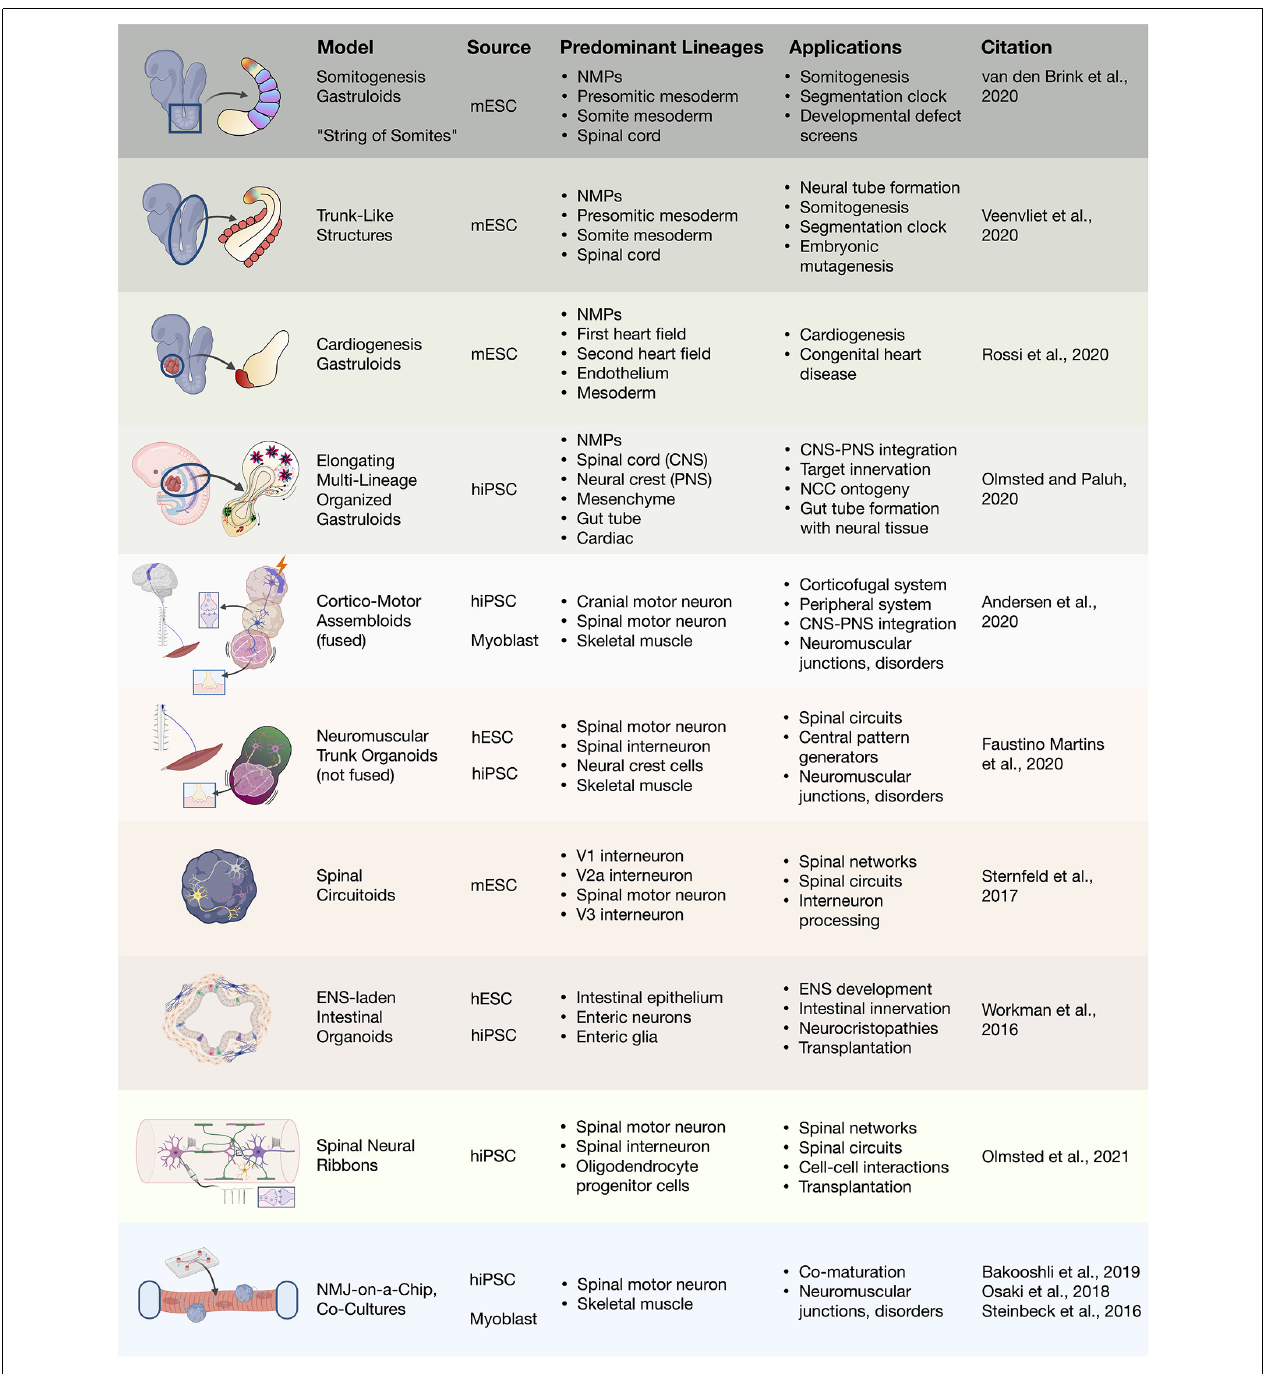
FIGURE 4 | 3D heterogenous cell culture developmental models and biotechnologies. Overview of stem cell integration with biotechnologies to produce developmental neurotechnologies. In vitro 3D heterogenous cell culture systems include gastruloids, organoids, and assembloids that can be merged with biomaterials, microfluidics, and devices. mESC, mouse embryonic stem cell; hiPSC, human induced pluripotent stem cell; hESC, human embryonic stem cell; NMJ, neuromuscular junction.